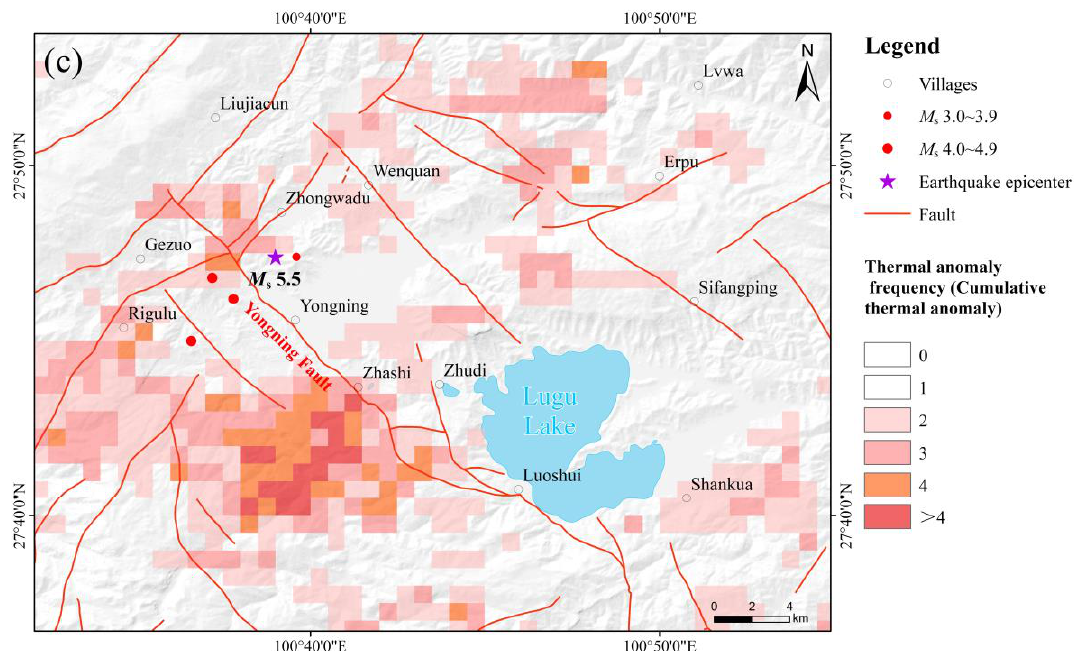
Figure 13. ( a ) The frequency statistics of preseismic thermal anomalies; ( b ) The frequency statistics of postseismic thermal anomalies; ( c ) The frequency statistics of 23 thermal anomalies .